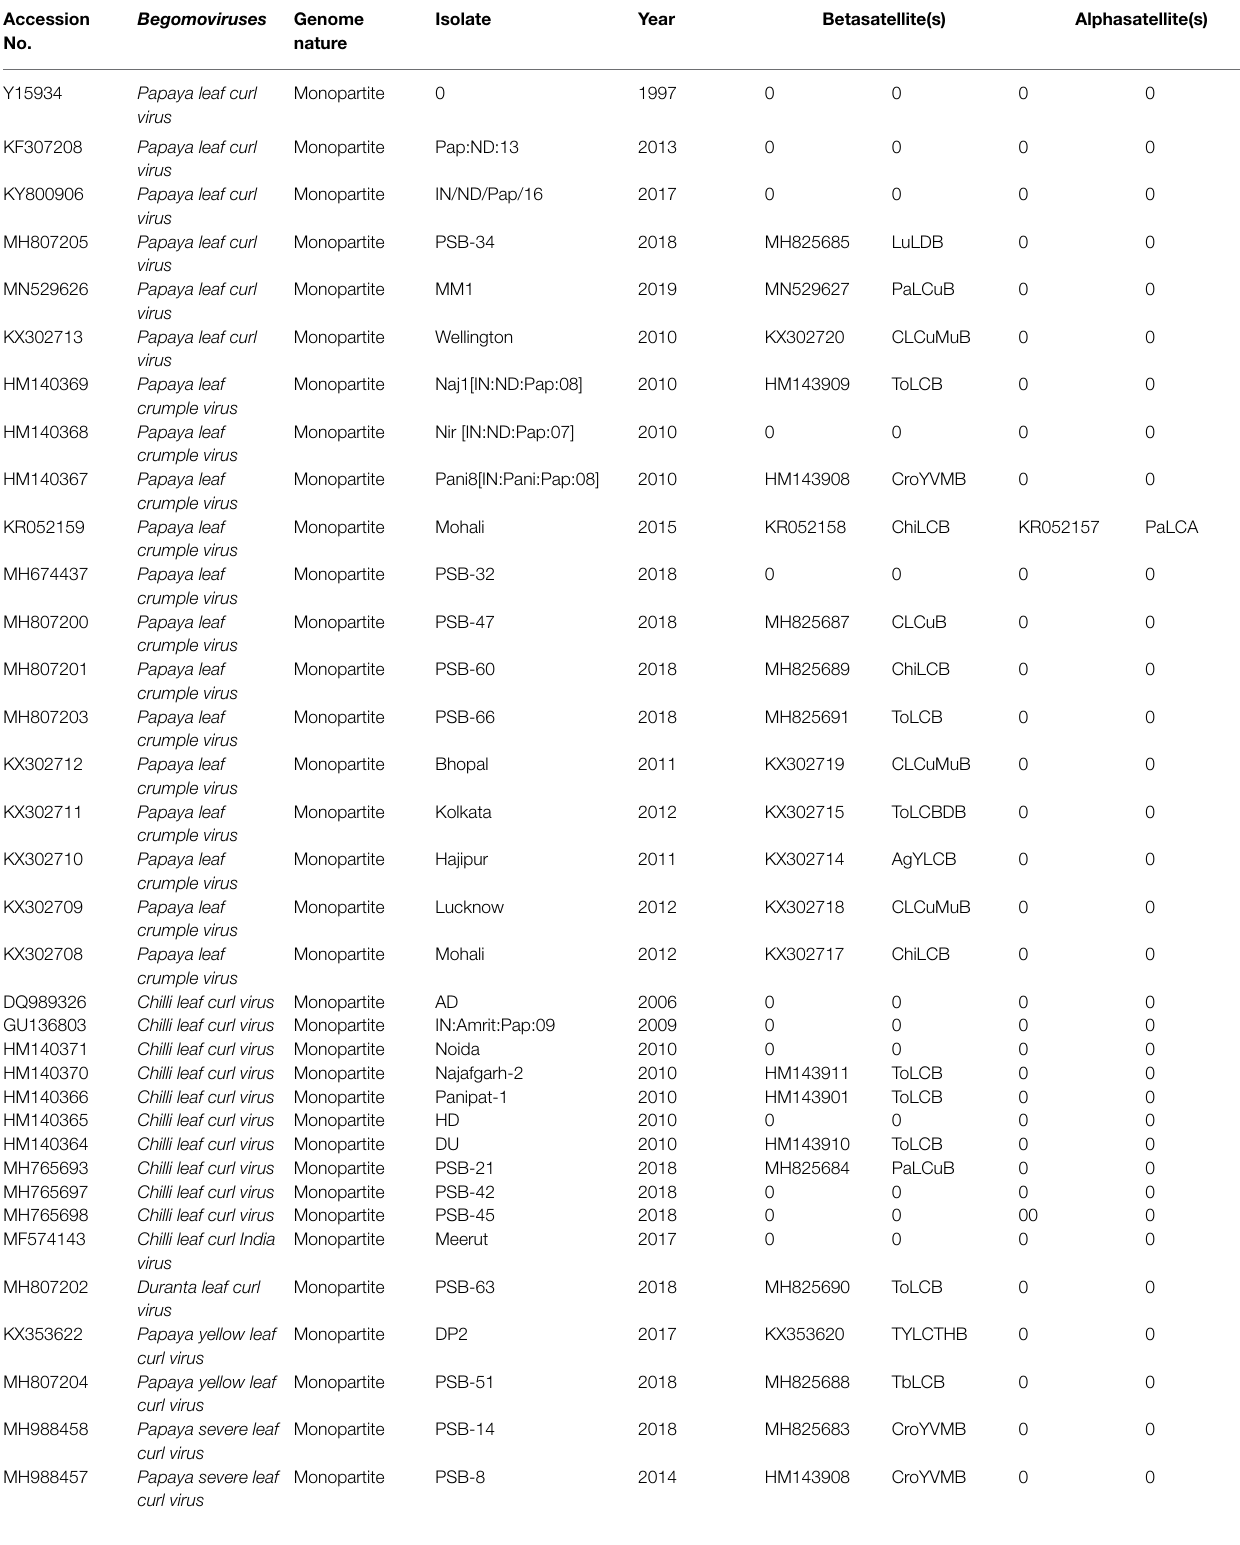
TABLE 1 | Features of begomoviruses and associated satellites causing leaf curl disease in papaya plants are identified in India. Accession